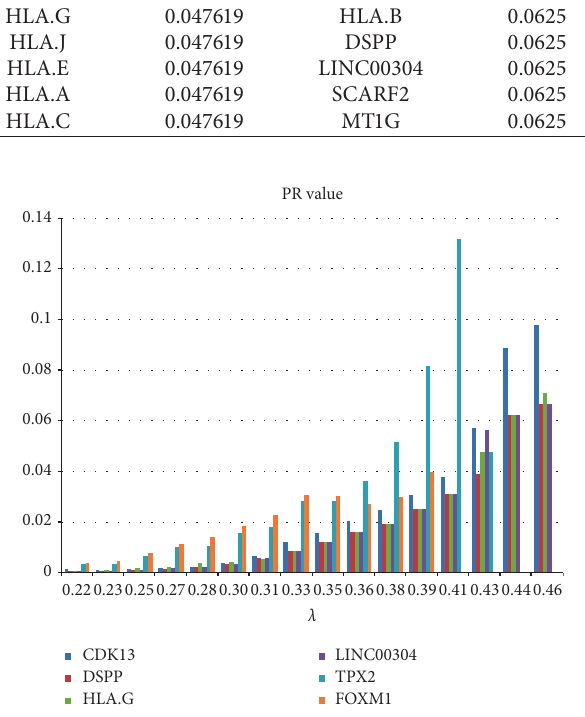
Figure 11: Comparison of PR values of genes with different values. Table 5: The biological significance of some key genes.